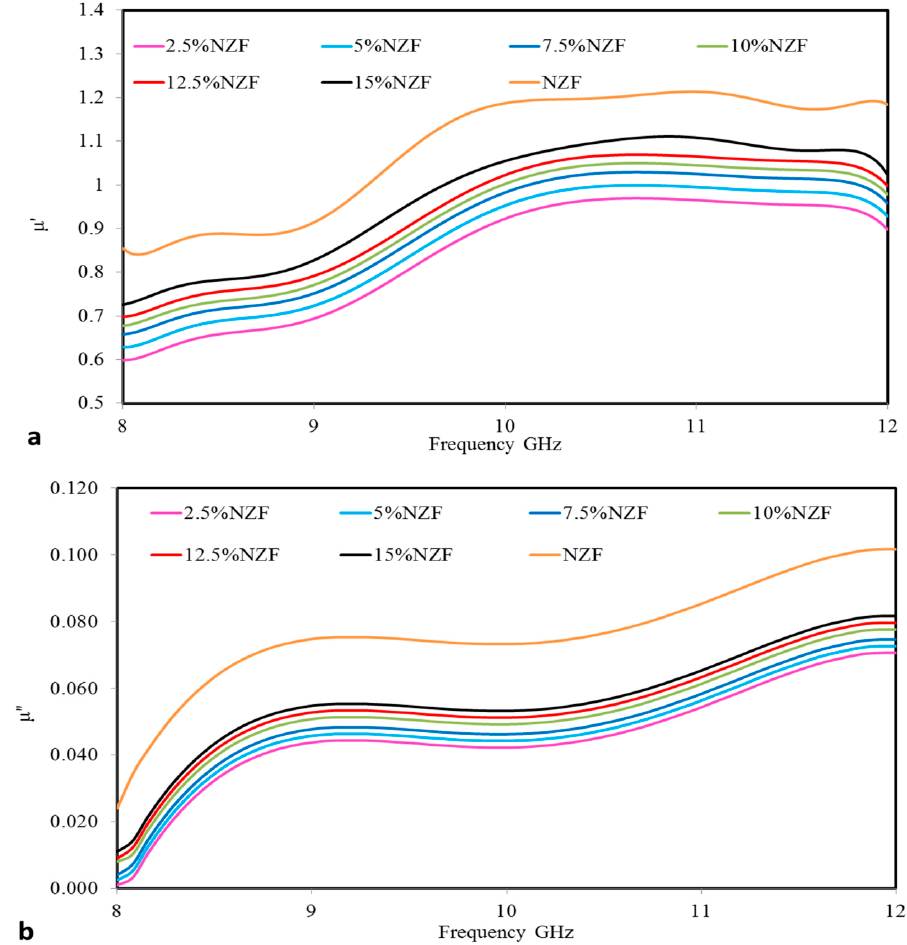
Figure 8. Frequency dependence of ( a ) real part of the effective magnetic permeability ( μ′ ) and ( b ) imaginary part of effective magnetic permeability ( µ ”) for NZF + OPEFB + PCL composites. Table 3. Variations in ε′ and ε″ values at 10 GHz.